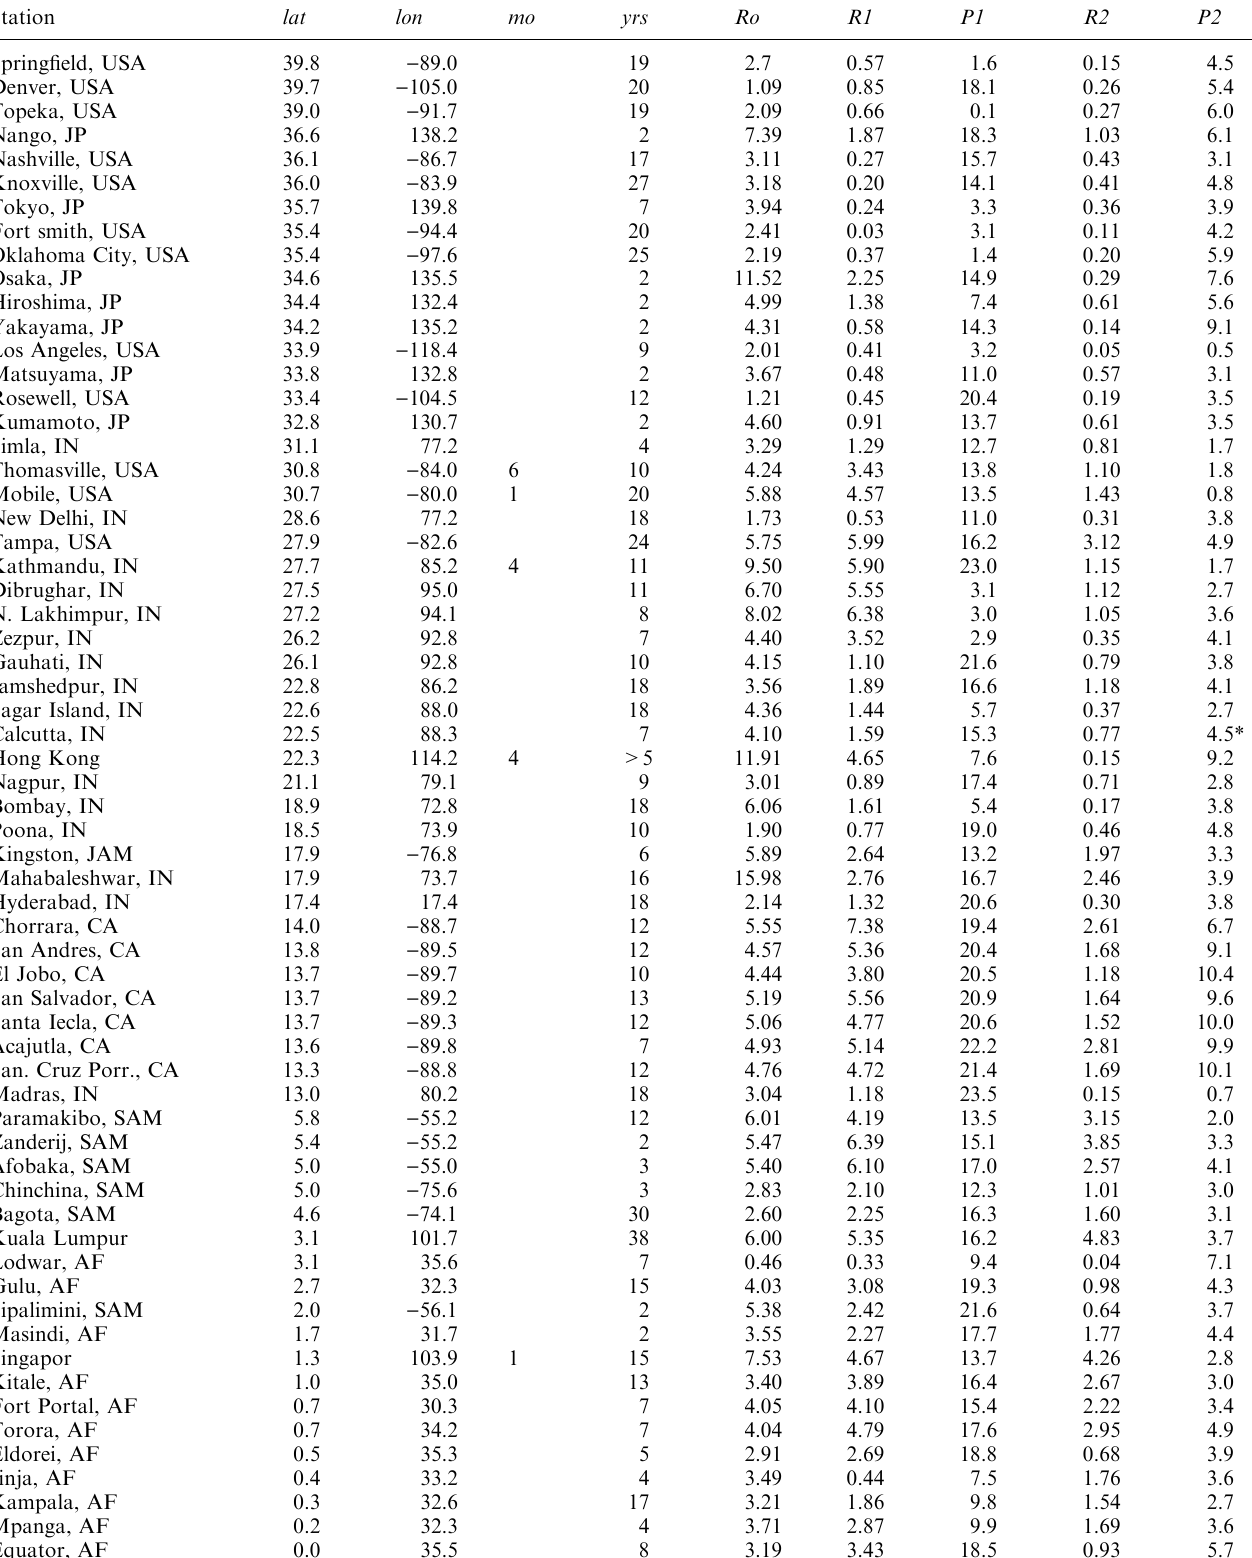
Table 2. Rain gauge data. Ro is the mean value of rainfall rate in mm day ) 1 ; R1 and R2 are the diurnal and semidiurnal amplitudes, and P1 and P2 are the diurnal and semidiurnal phases (local times of maxima), respectively. Latitude (lat), longitude (lon) and number of years (yrs) of data are given for each station. Some stations only had data during summer months, or months centered around summer; the number of months in these cases is listed under the column labeled mo (* assumes 1500 mm of rainfall per annum)